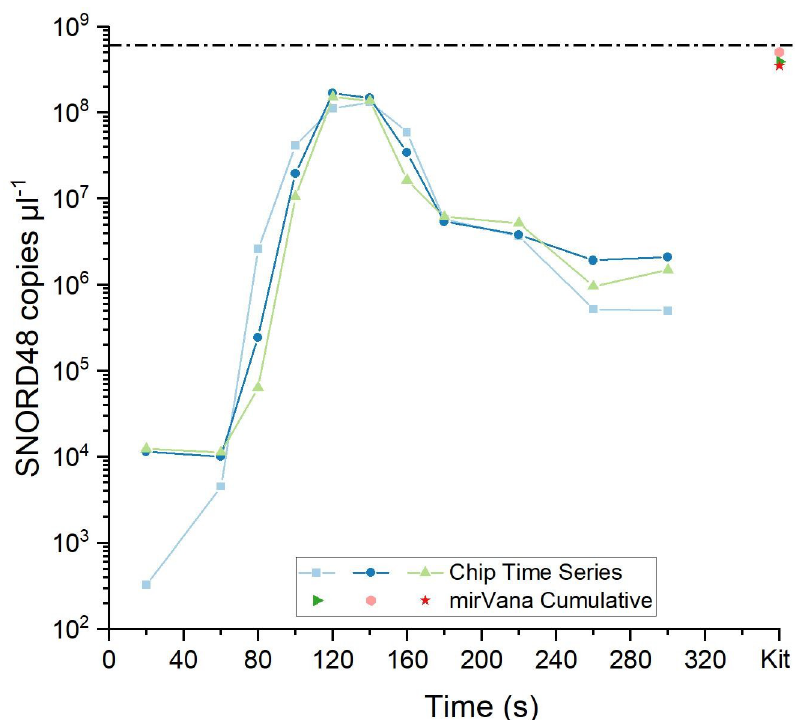
Fig 4. Comparison of GEE performance with mirVana miRNA extraction kit. Solid lines: GEE elution profile of SNORD48. Single points: SNORD48 extracted with the mirVana kit. Dashed line: Concentration of the input sample for GEE and kit extraction.